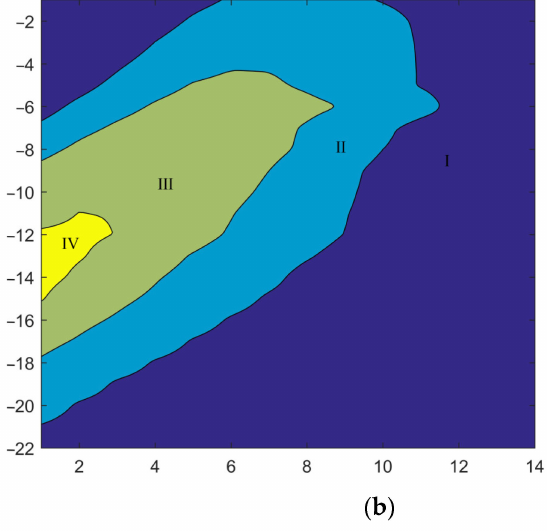
Figure 28. Adjacent influential partition based on safety factor: ( a ) cloud diagram of variation in safety factor and ( b ) schematic diagram of adjacent influential partition.